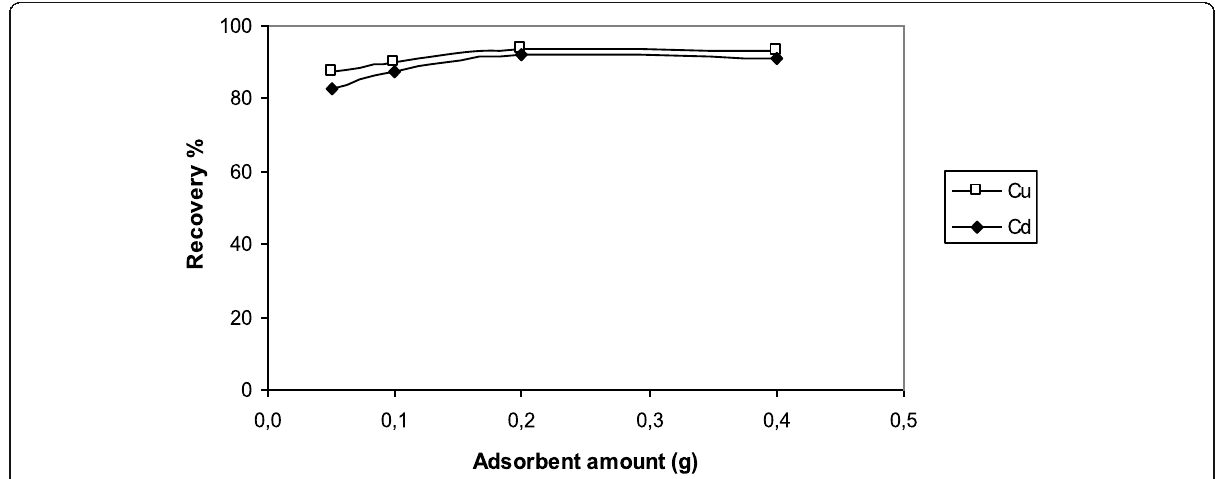
Fig. 2 Effect of amount of adsorbent on the recovery of Cu(II) and Cd(II) by Phanerochaete chrysosporium immobilized on